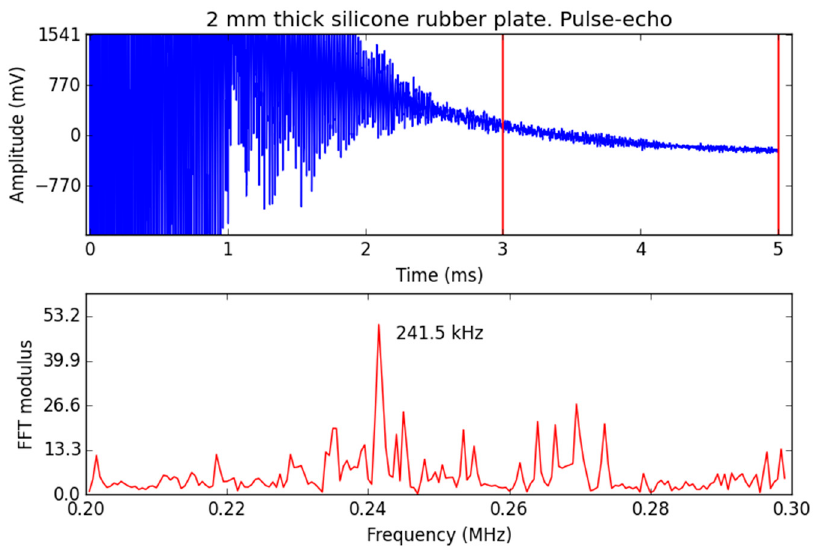
Figure 11. Pulse-echo; 2 mm-thick silicone rubber plate: signal in the time domain (top) and FFT modulus of the signal within the indicated window (bottom).